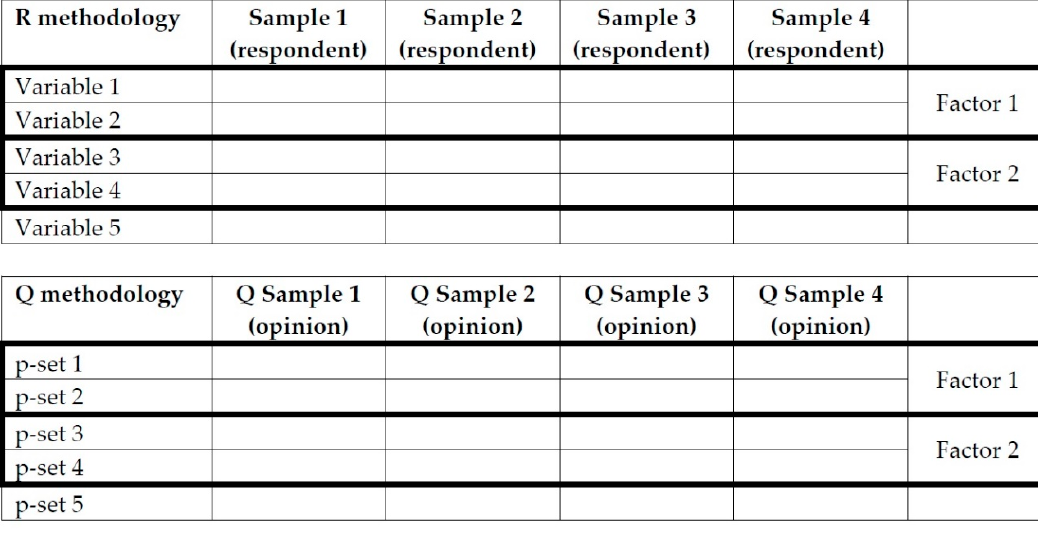
Figure 1. Difference between the R method and Q method.